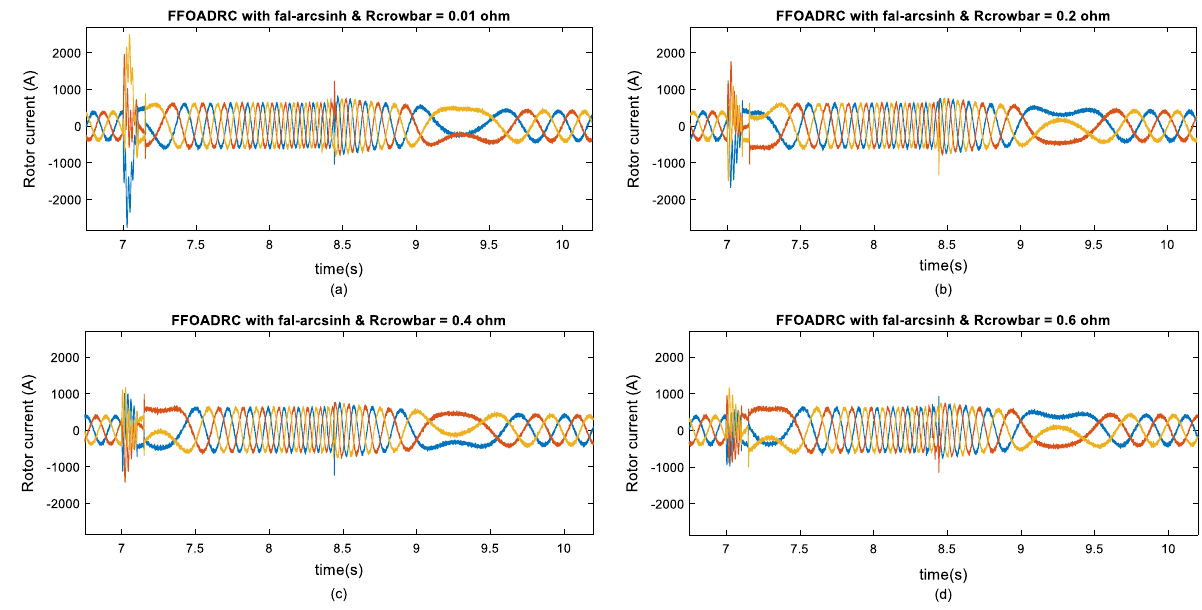
Fig. 28 Rotor current of the DFIG during symmetrical voltage swell for different values of R crowbar . ( a ) R crowbar R crowbar 0.4 ohm, and ( d ) R crowbar =